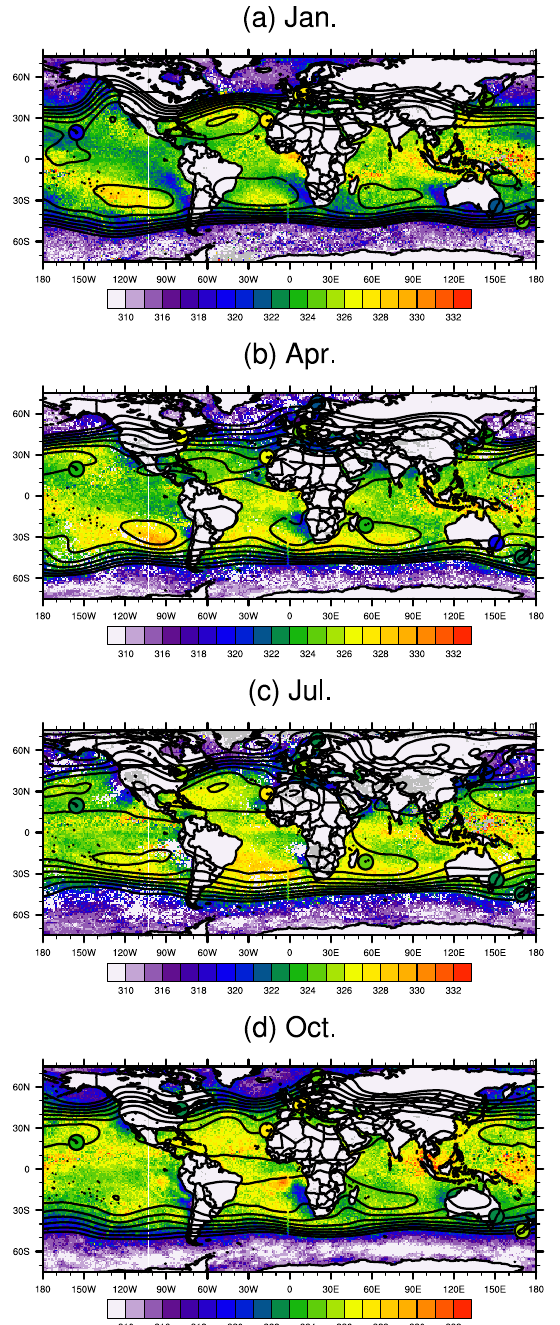
Figure 12. Global distributions of nighttime SOFRID MT N 2 O over Sea for ( a ) January, ( b ) April, ( c ) July and ( d ) October 2014. The black lines represent the 700 hPa geopotential heights between 2920 m and 3260 m every 40 m. Filled circles at the locations of the 12 NDACC stations correspond to the monthly mean FTIR MT N 2 O